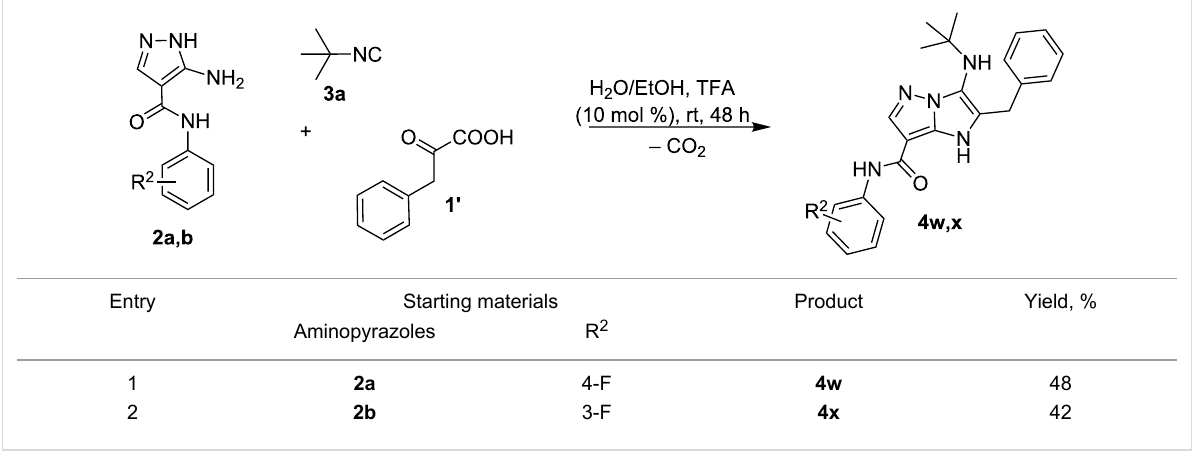
Table 5: GBB-3CR involving ethyl